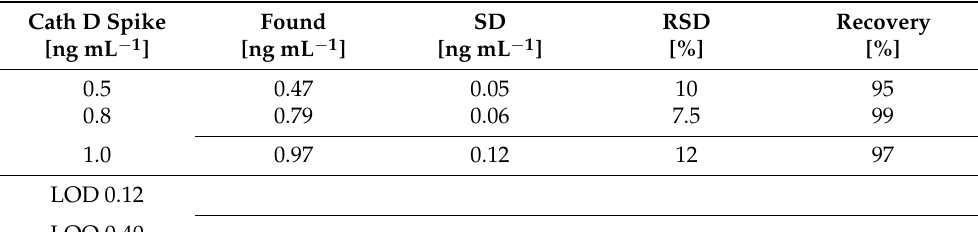
Table 3. Precision and recovery of Cath D determination using the biosensor with a pure gold chip and two-paint separating polymer.